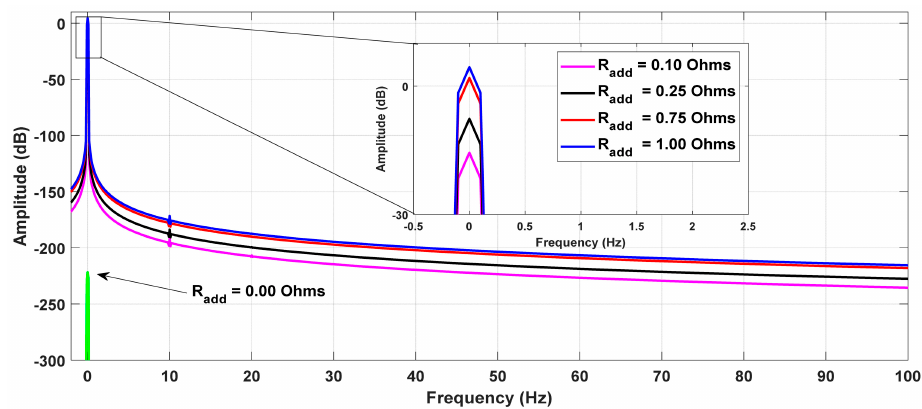
Figure 9. Simulation results: spectra of the proposed fault index under healthy and di ff erent HRC conditions a ff ecting Phase a1.